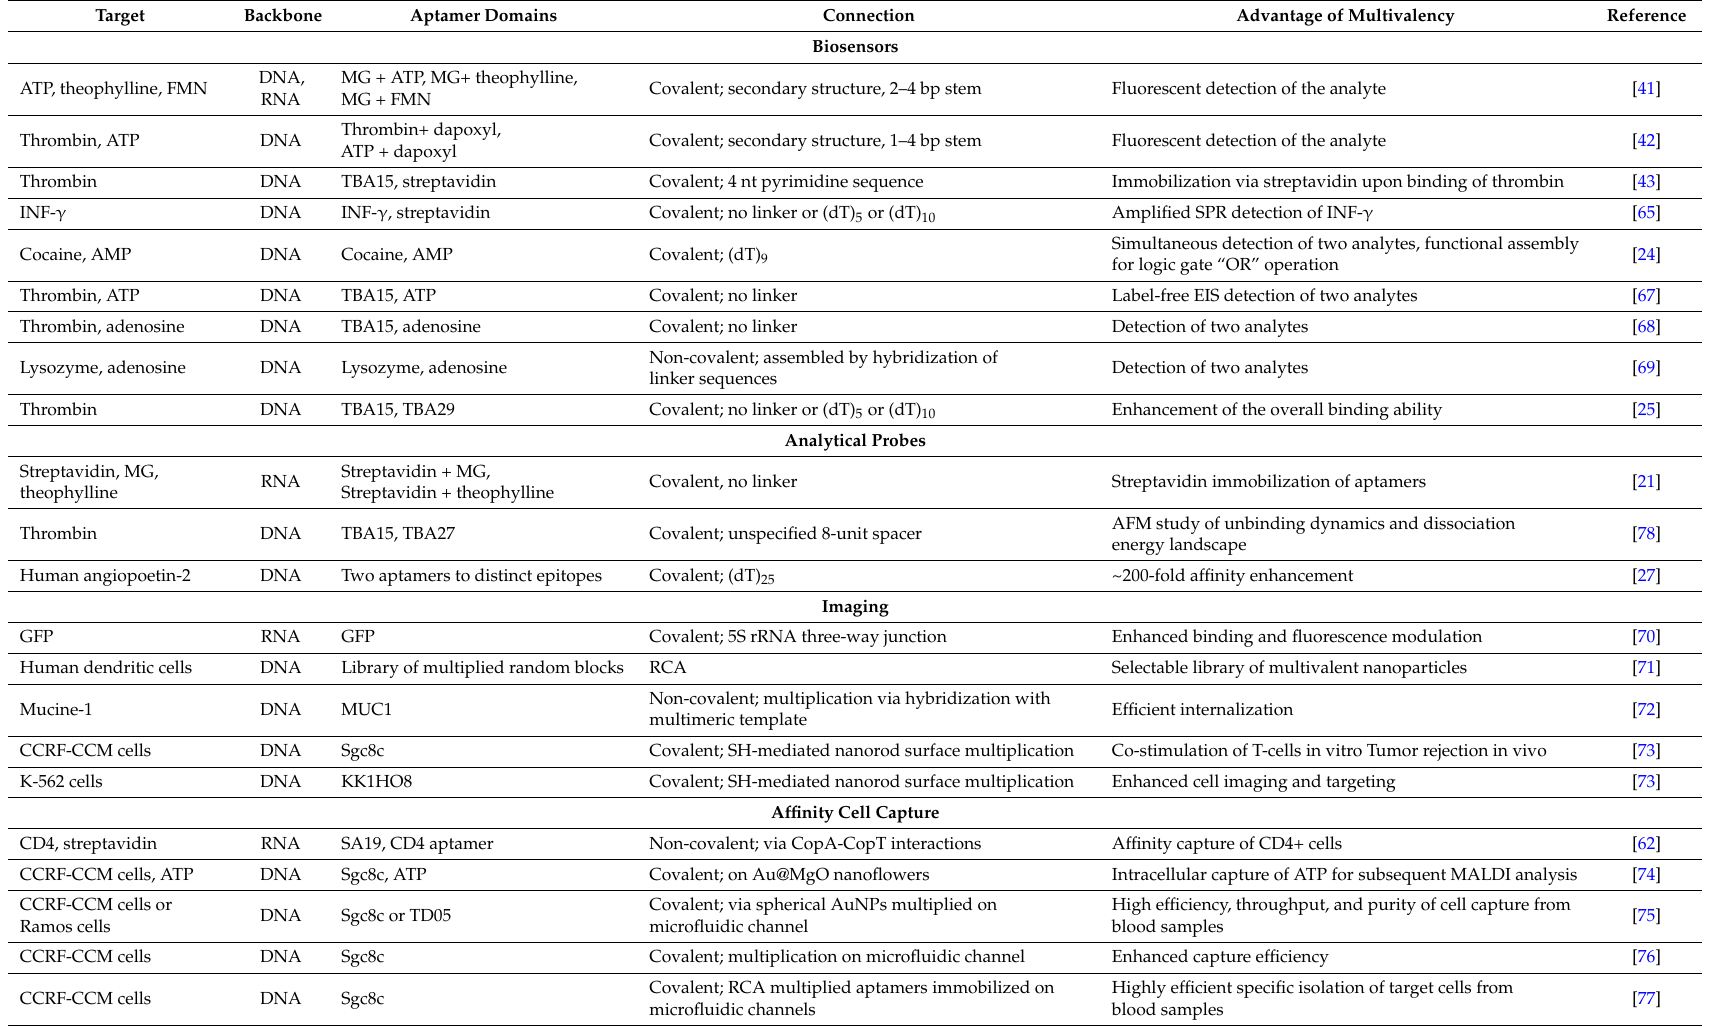
Table 1. Summary of multivalent aptamer constructs for bioanalytical